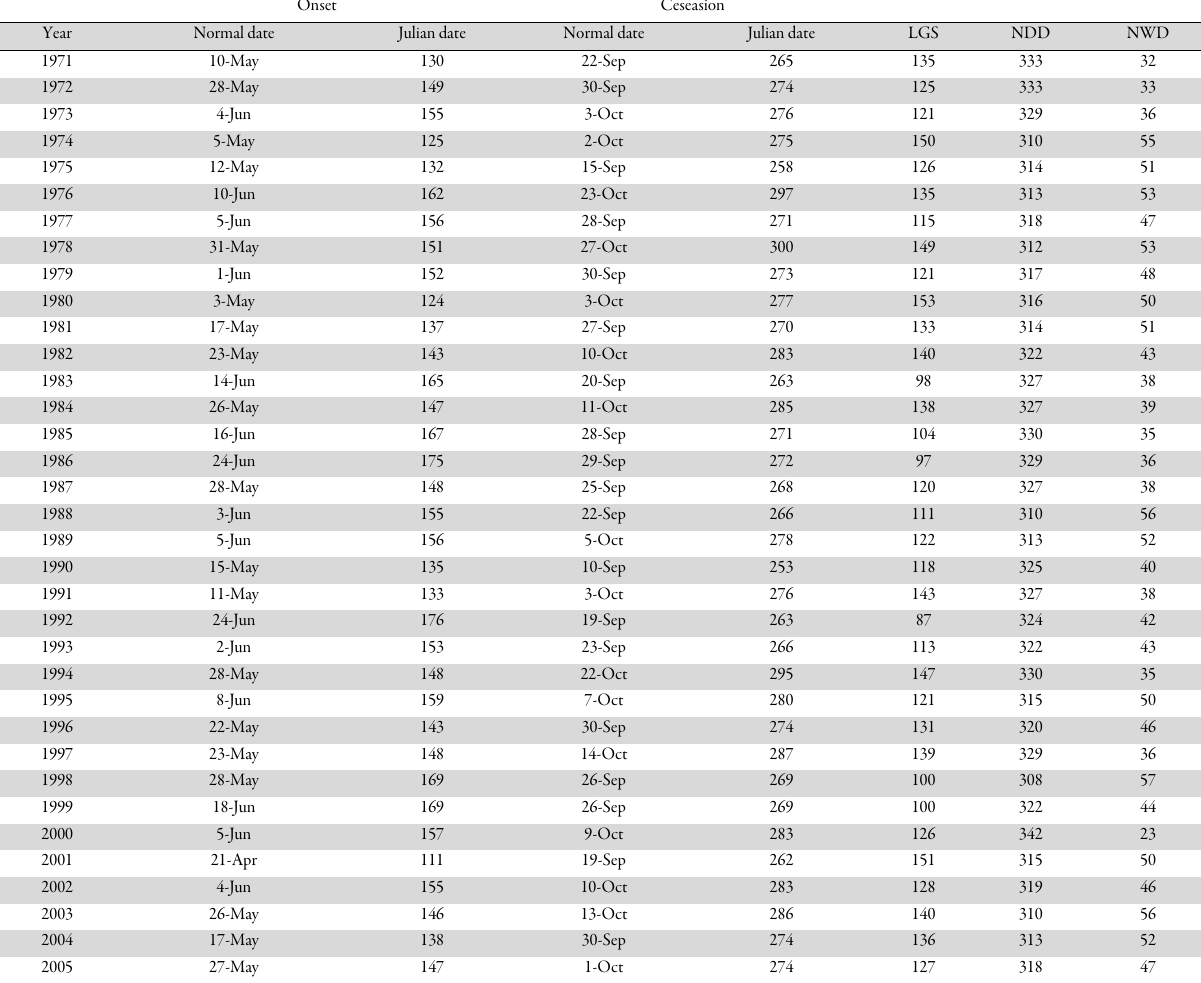
Table 6. Onset, cessation, length of growing season (LGS), number of dry days (NDD) and number of wet days (NWD) in Katsina Onset